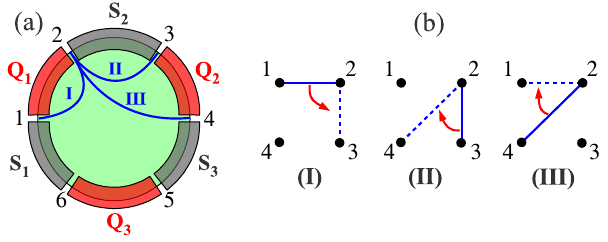
FIG. 2. Braiding process. (a) A FTI disk with six SC-FM segments. In stages I, II, and III of the braiding process, quasiparticle tunneling (represented by blue curves) is turned on between the SC-FM interfaces. (b) Representation of the braiding procedure, involving interfaces 1, 2, 3, and 4. In the beginning of each stage, the two interfaces connected by a solid line are coupled; during that stage, the bond represented by a dashed line is adiabatically turned on, and, simultaneously, the solid bond is turned off. By the end of stage III, the system returns to the original